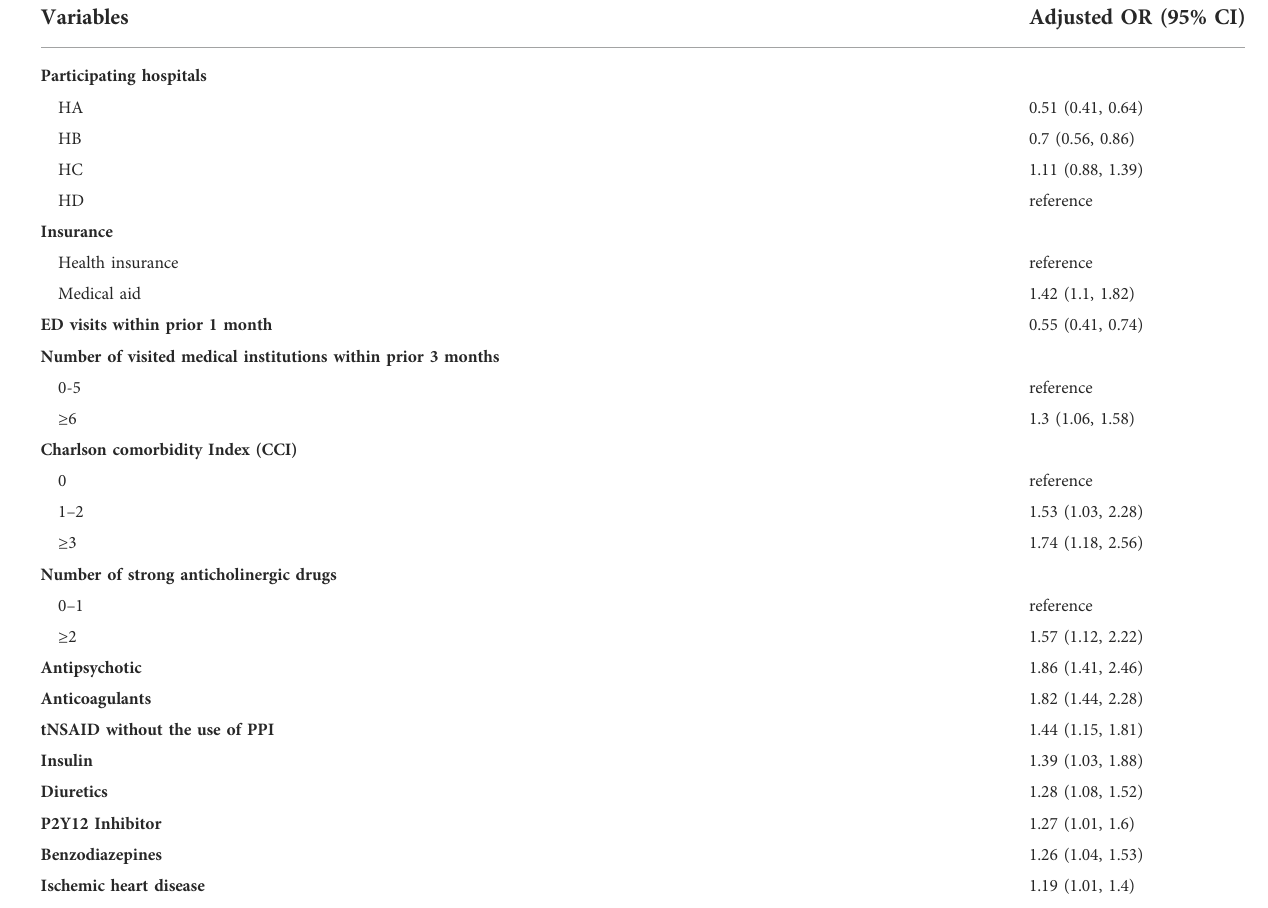
TABLE 4 Predictors of medication-related emergency department